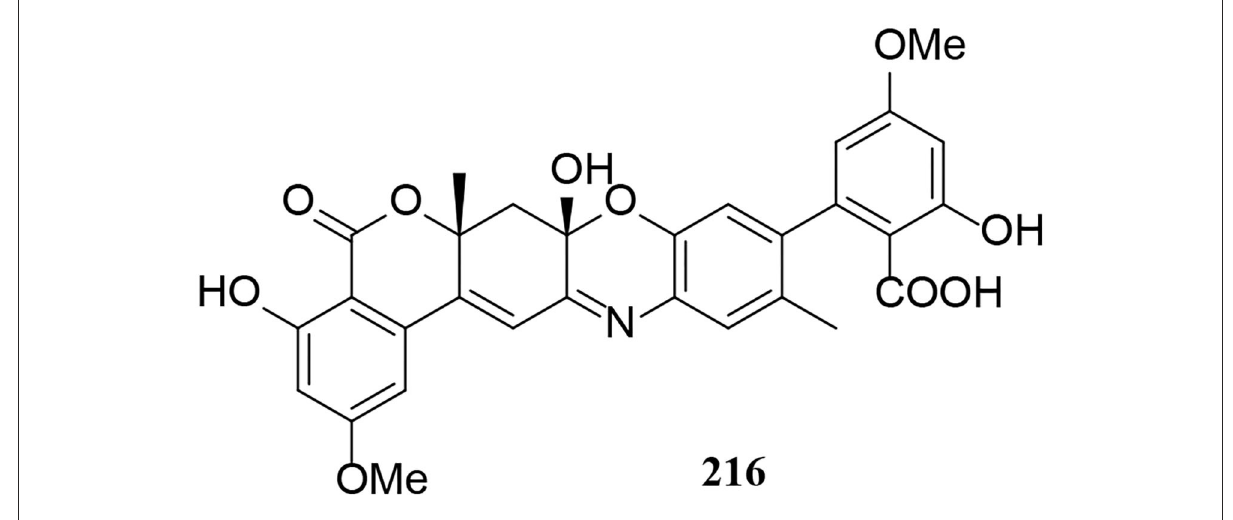
FIGURE13 Other derivative ( 216 ) from Alternaria